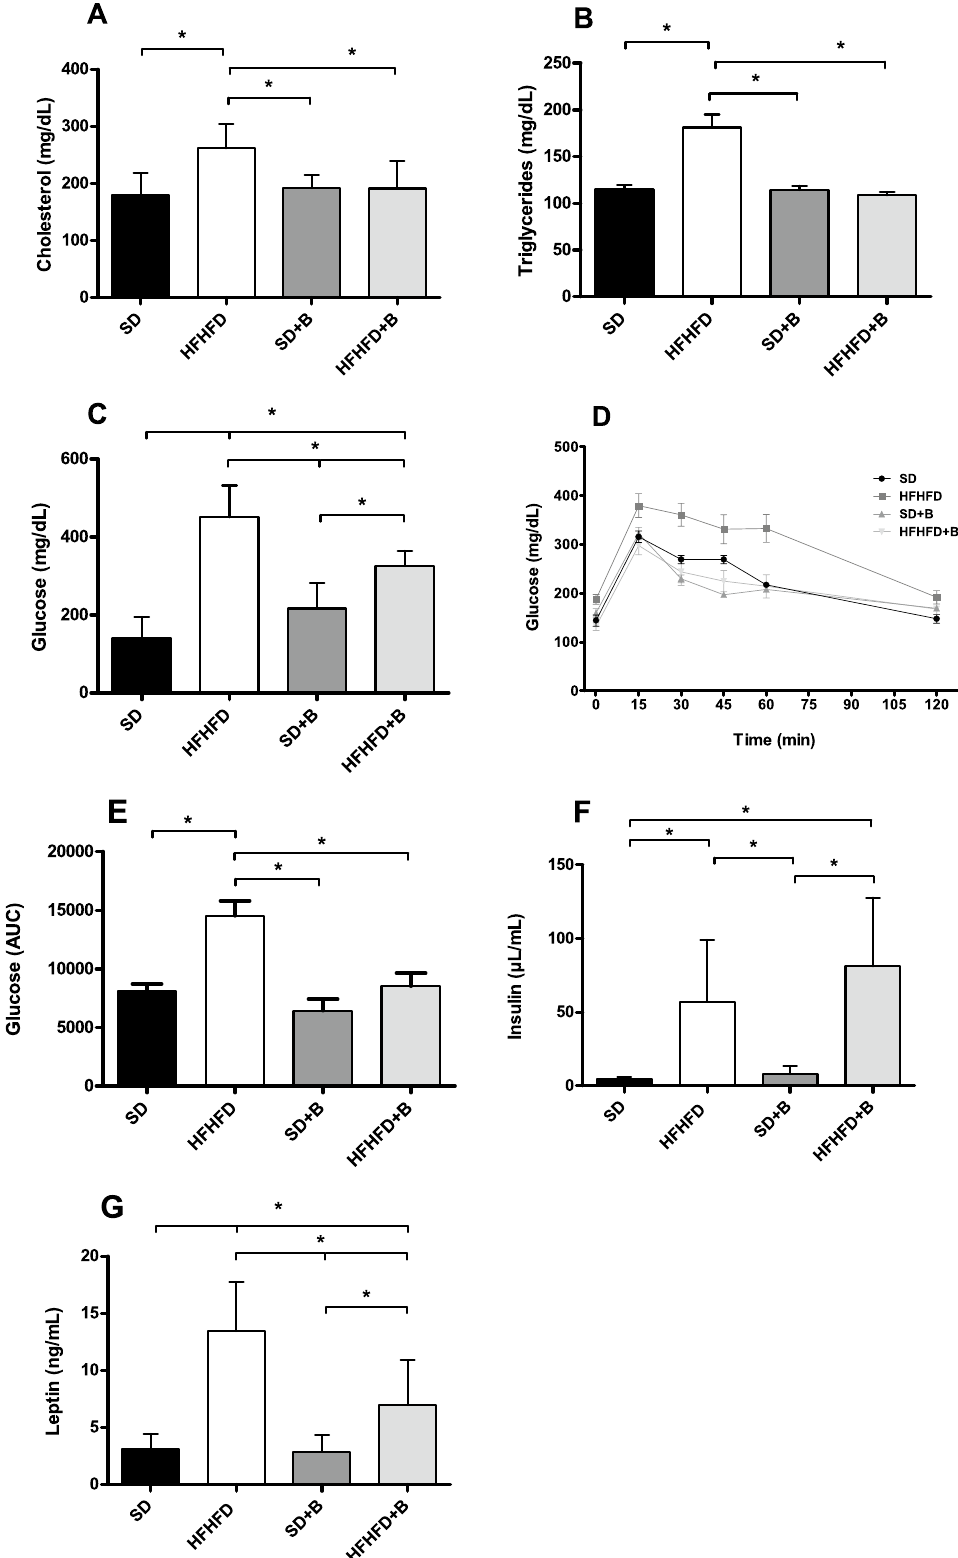
Figure 2. Plasma concentrations of ( A ) cholesterol, ( B ) triglycerides, ( C ) glucose, ( D ) glucose levels for individual time points in a glucose tolerance, ( E ) AUC values for glucose in a GTT, ( F ) insulin and ( G ) leptin. Data are expressed as mean and standard error (vertical bars). Statistically significant differences were established by ANOVA and post hoc student t test ( p <